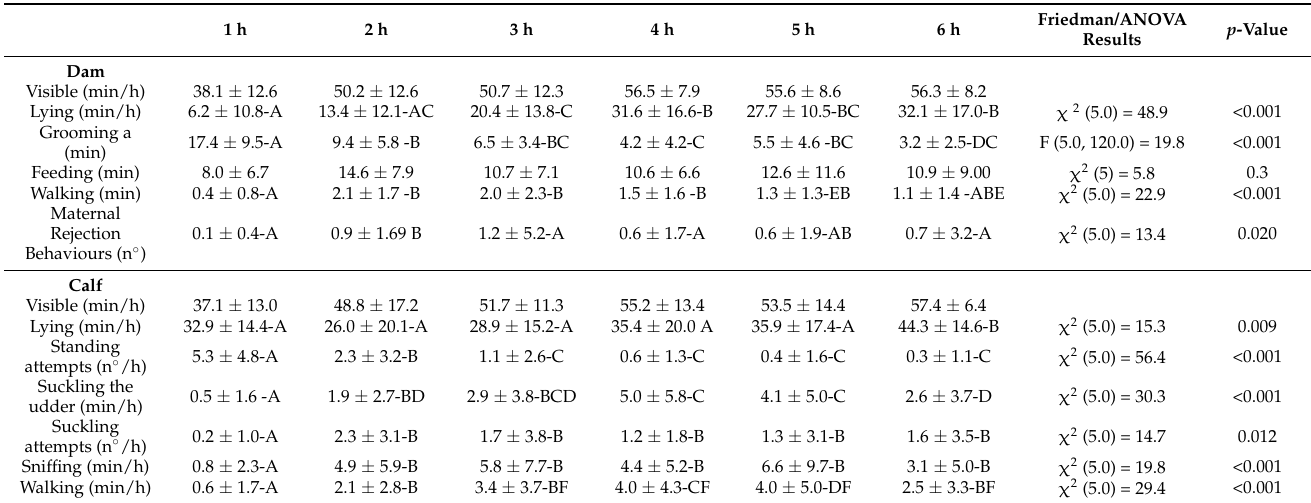
Table 5. Behaviours during the hourly intervals in the first six hours after calving.